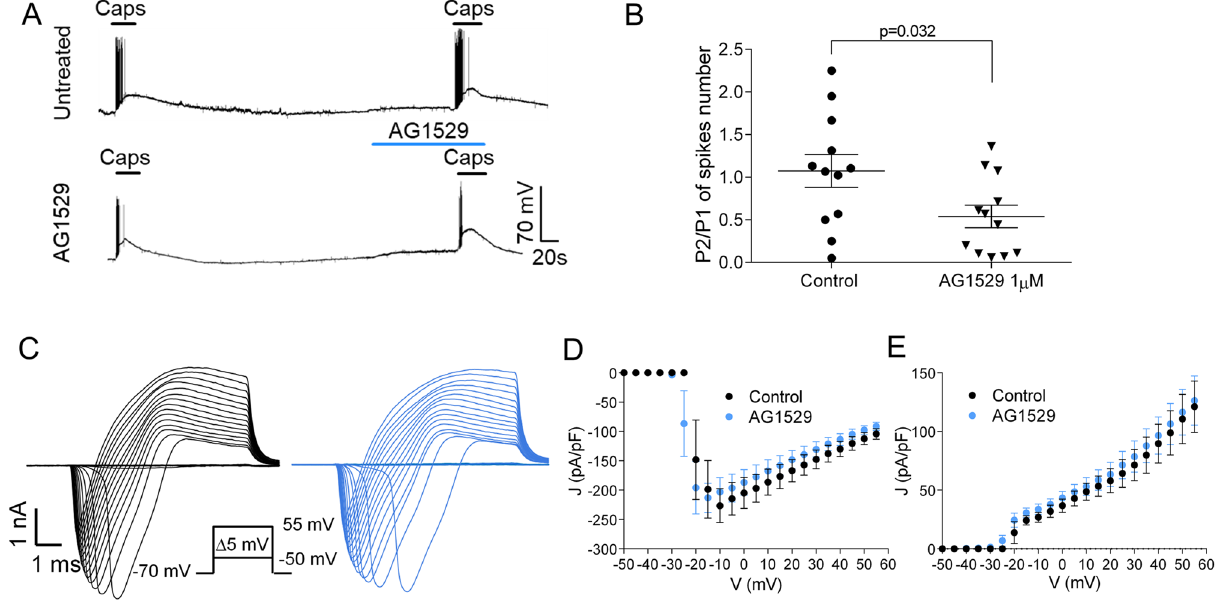
Figure 5. AG1529 affects capsaicin-evoked nociceptor firing. ( A ) Representative recordings of APs firing from DRG neurones elicited by 0.5 μM capsaicin in the absence (Untreated) and presence (AG1529) of 1 µM AG1529. APs were recorded under current clamp mode. Horizontal lines denote the duration of compound pulse. ( B ) Ratio of second (P2) versus first (P1) peak of APs evoked by capsaicin application in the absence (n = 12) and the presence during the P2 of 1 µM AG1529 (n = 12). ( C ) Representative macroscopic ionic currents evoked by a series of depolarizing 5 mV voltage steps of 10 ms, from − 50 mV to 55 mV from a holding potential of − 70 mV, in the absence (black) and the presence (blue) of 1 µM AG1529. ( D ) and ( E ) current density to voltage relationships for the inward and outward currents of panel ( C ), respectively. All data are expressed as mean ± SEM. Data depicted in panel ( B ) was analysed using an unpaired, two-tail Student’s t-test. p-value is